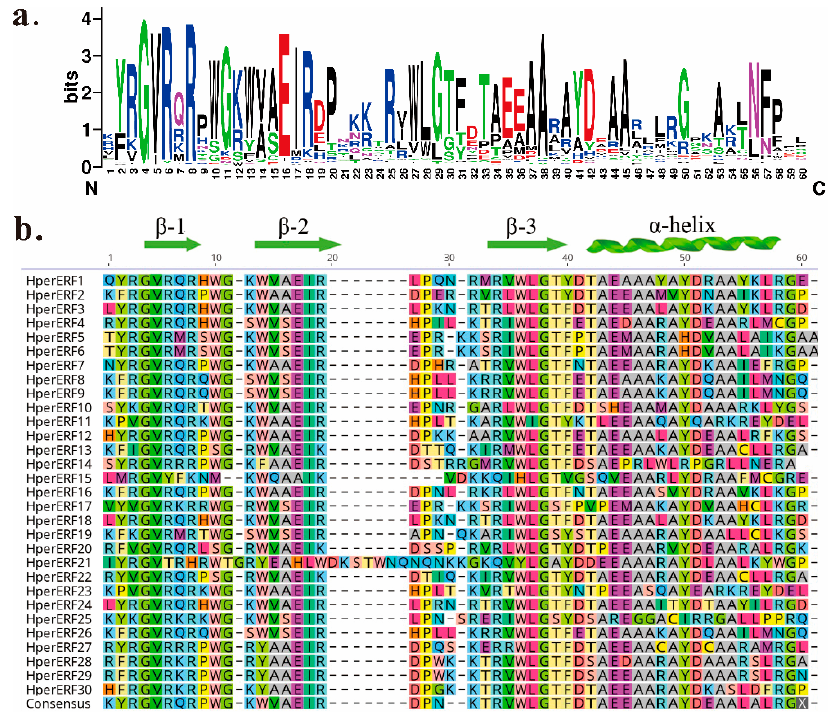
Figure 1. The sequence logo and multiple alignment analysis of the AP2/ERF domain. ( a ) The sequence logo of the AP2/ERF domain is displayed. ( b ) Multiple alignment analysis of the AP2/ERF domains was performed. The shading in different shapes and colors indicate the same and conserved amino acid residues, respectively. The green arrows and helix display the α -helix and β -sheet regions of the AP2/ERF domain, respectively.